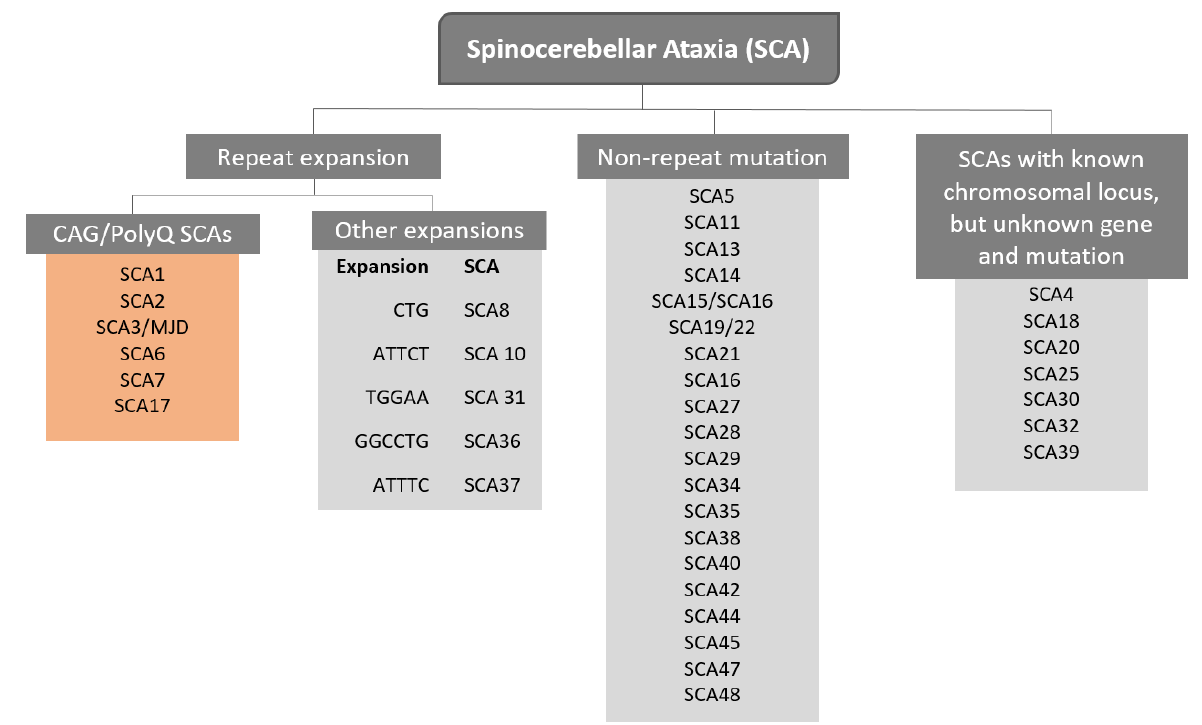
Figure 1. Representation of genetic classification of spinocerebellar ataxias. PolyQ SCAs are caused by an abnormal CAG trinucleotide repeat expansion within the coding region of the causative gene that encodes for the glutamine amino acids, generat- ing an expanded polyglutamine protein. The repeat expansion size varies from individuals, being related to the disease severity, and the age onset, that is, individuals with higher CAG repetitions display an early onset of the symptoms, which are also more severe [11]. PolyQ SCAs are also characterized by the anticipation of the age onset, explained by intergenera- tional instability biased towards expansions. Additionally, somatic mosaicism was also reported as being associated with the age of onset and the severity of the symptoms